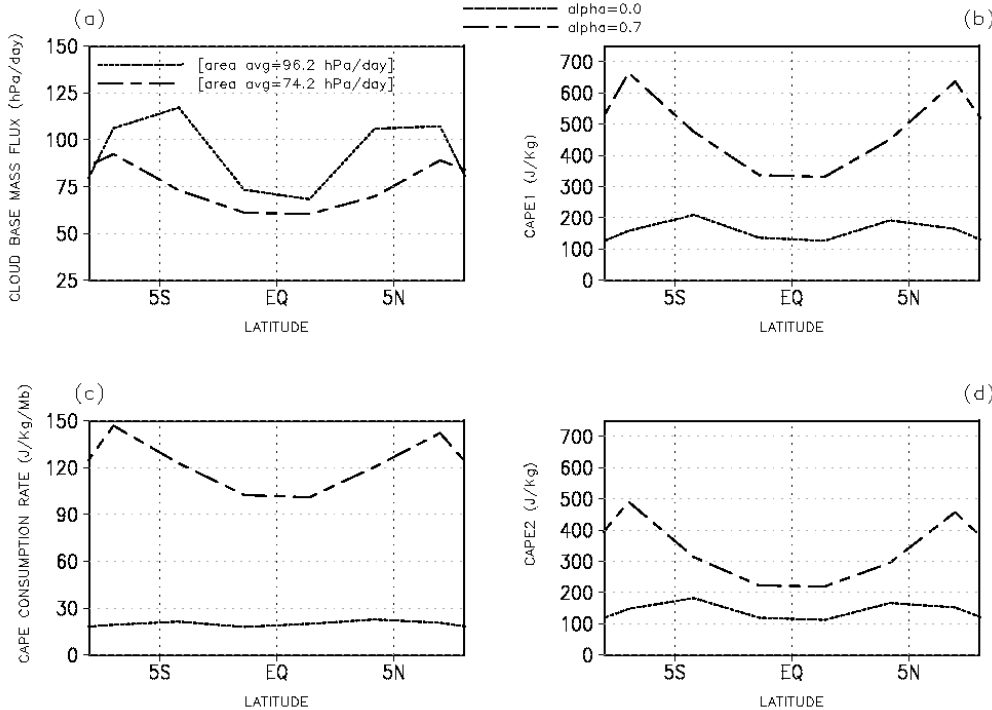
Fig. 7. Zonally averaged time mean quantities for α =0 and α =0.7. (a) cloud base mass flux (hPa/day), (b) CAPE just before the deep convective scheme is invoked (J/kg), (c) CAPE consumption rate (J/kg/M b ) , (d) CAPE just after computations in deep convective scheme